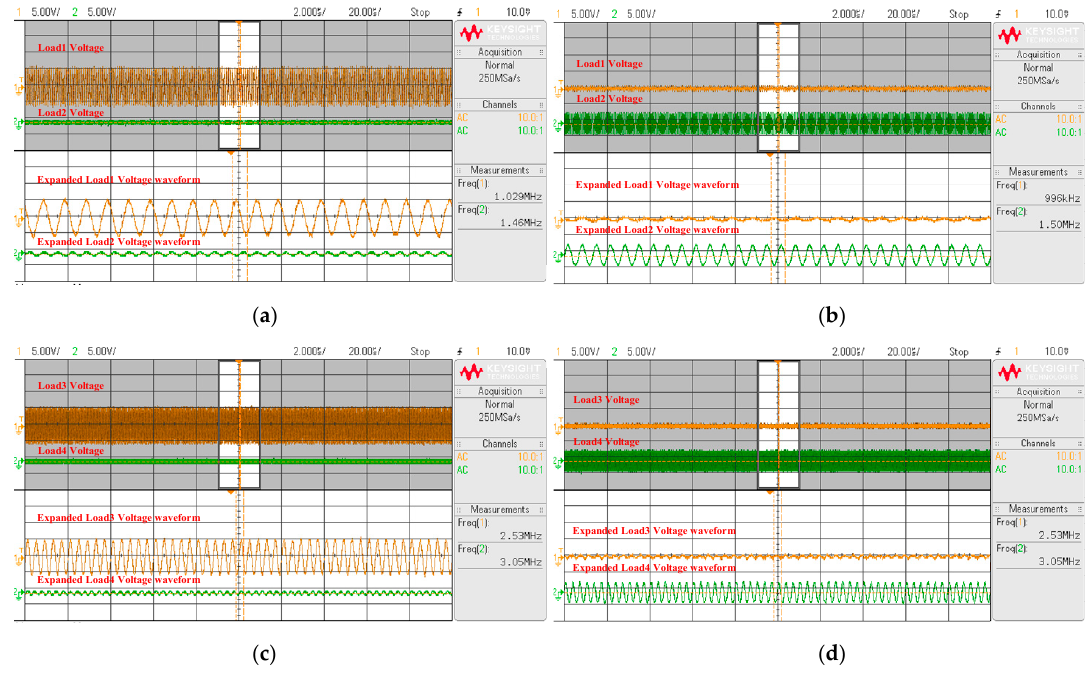
Figure 16. Measured load voltage of selective WPT system. ( a ) (cid:1858) = 1 MHz; ( b ) (cid:1858) = 1.5 MHz; ( c ) (cid:1858) = 2 MHz; ( d ) (cid:1858) = 3 MHz.